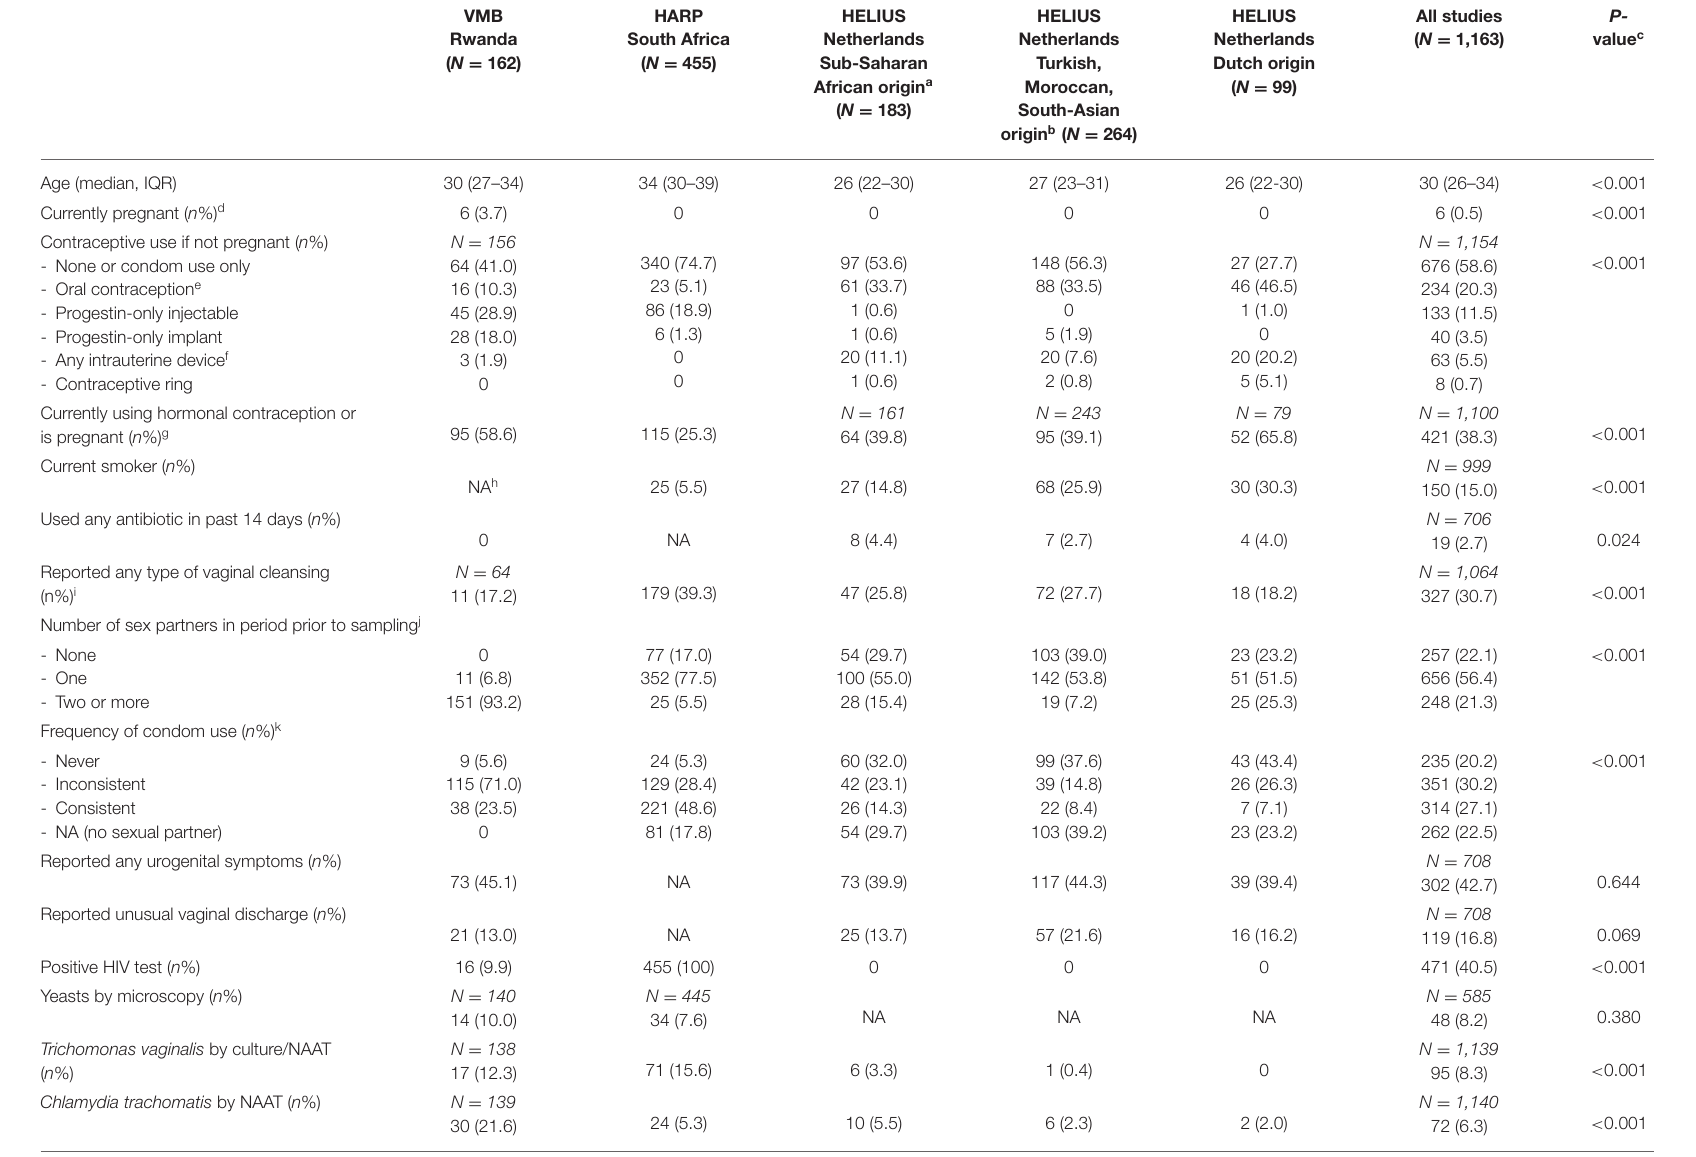
TABLE 2 | Baseline characteristics by study, and by ethnic group within the HELIUS